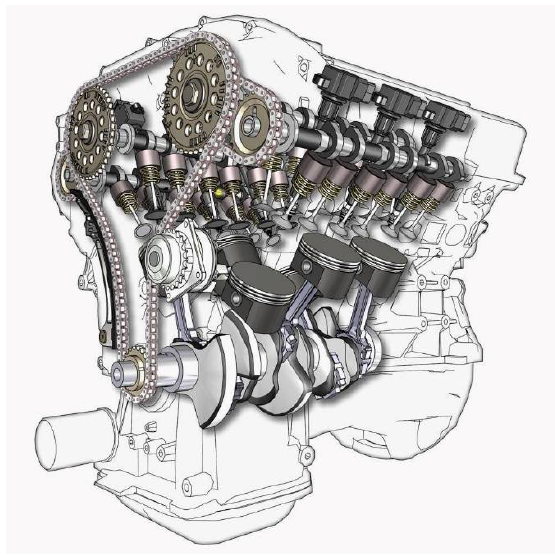
Figure 11. Diagram of the V Six-Cylinder Engine [63].